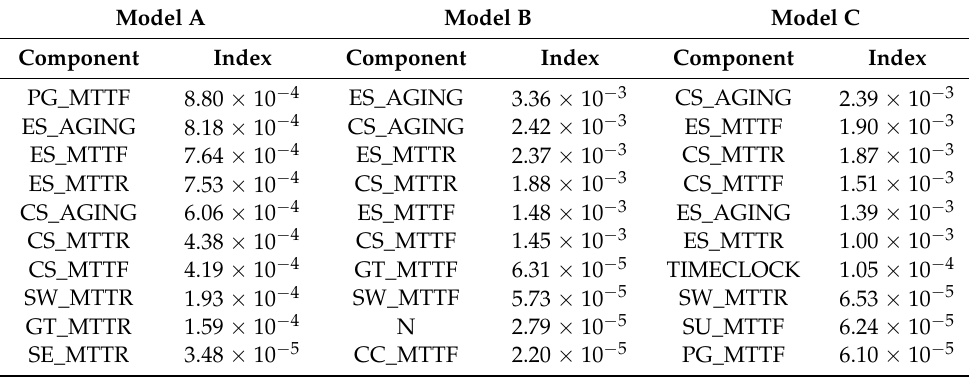
Table 6. Sensitivity analysis results for the 3 availability